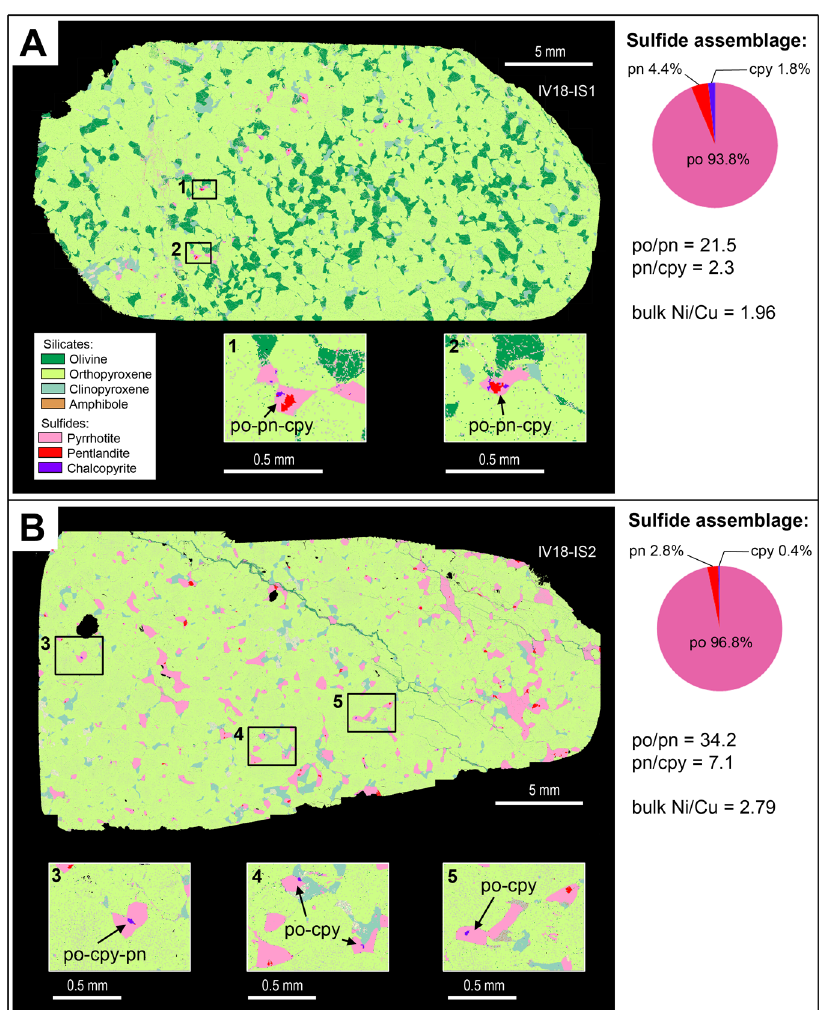
Fig. 2 ZEISS Mineralogic maps and quantitative sul fi de assemblages of polished thin sections from the Isola Sill. A an orthopyroxene-olivine cumulate with interstitial sul fi des of pyrrhotite (po), pentlandite (pn) and chalcopyrite (cpy); B an orthopyroxene cumulate with interstitial sul fi des. Quantitative data and sul fi de ratios are also presented in Supplementary Data